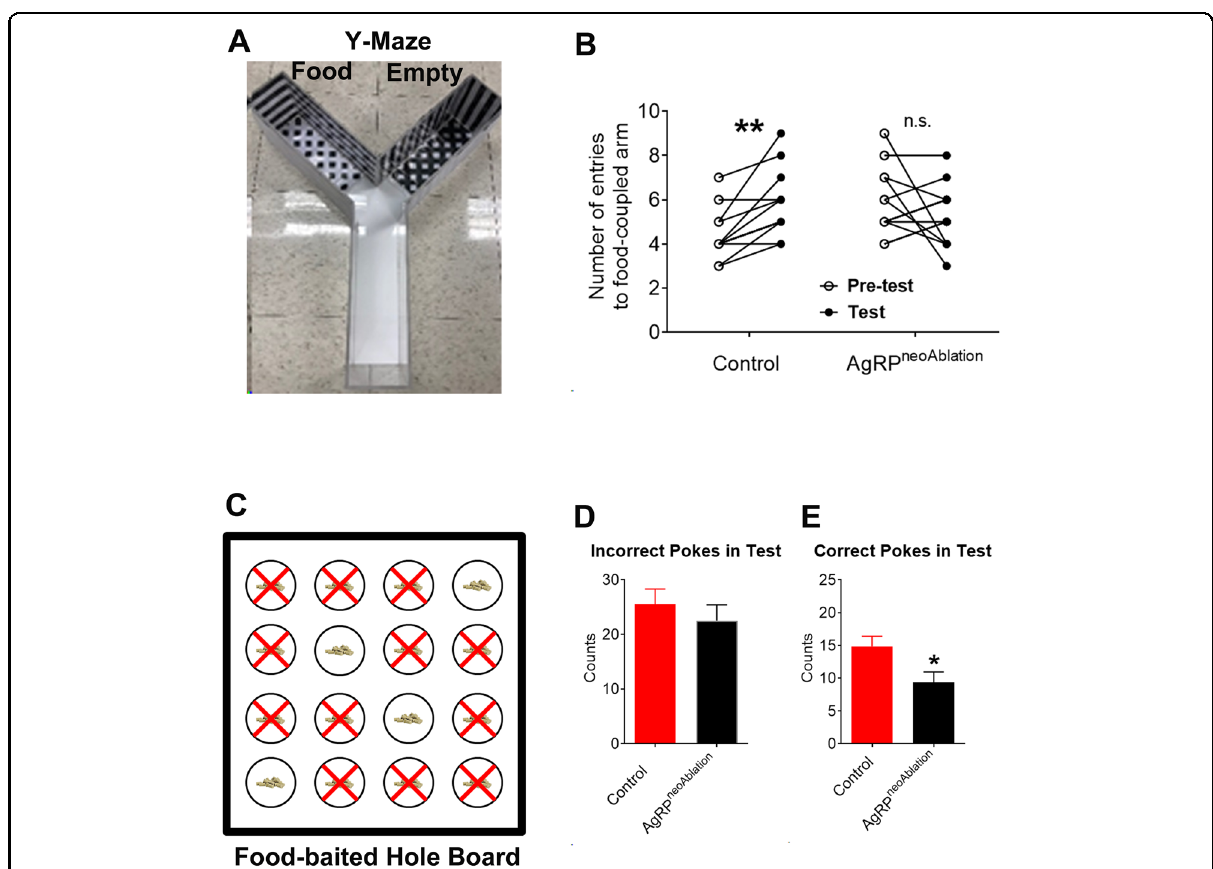
Fig. 4 Loss of AgRP neurons impairs food seeking. A A photo of the Y-maze. B Number of entries to food-coupled arm by control and AgRP neoAblation mice during pre-test and test in the Y-maze assay. n = 14 or 15 per group. ** P < 0.01 between pre-test and test in two-way ANOVA repeated measurement followed by post-hoc-Sidak tests. Note that the number of data points may appear fewer than the n values because multiple mice showed the same number of entries during the pre-test or test. C Schematic presentation of the hole-board with food baits. D , E Incorrect ( D ) and correct pokes ( E ) of control and AgRP neoAblation mice in the food-baited hole board test. Data are mean ± SEM. n = 16 or 17 per group. * P < 0.05 vs. control in two-tailed unpaired t tests. Also see Fig.